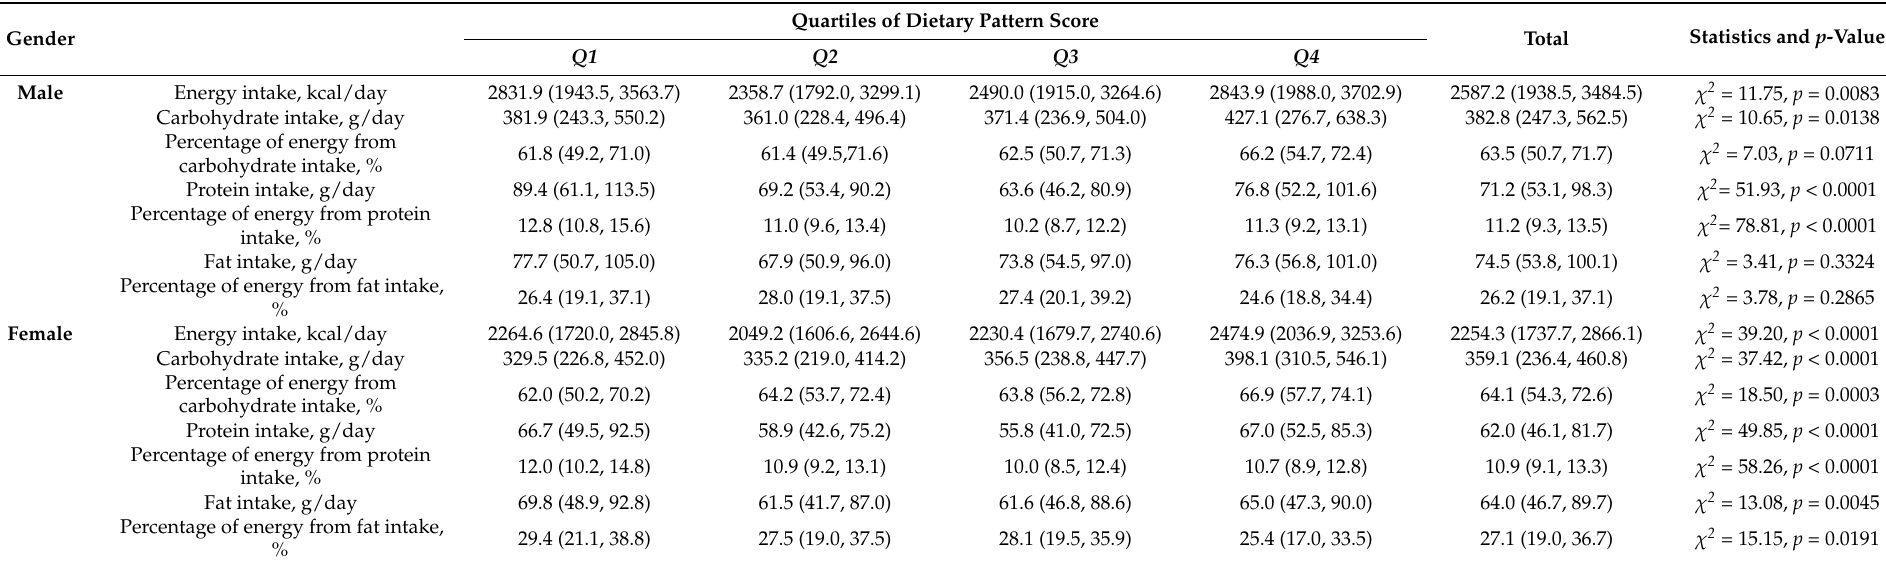
Table 4. Macronutrient intake and percentage of energy from macronutrient intake analyzed by quartile levels of dietary-pattern score in this study (M ( P 25 , P 75